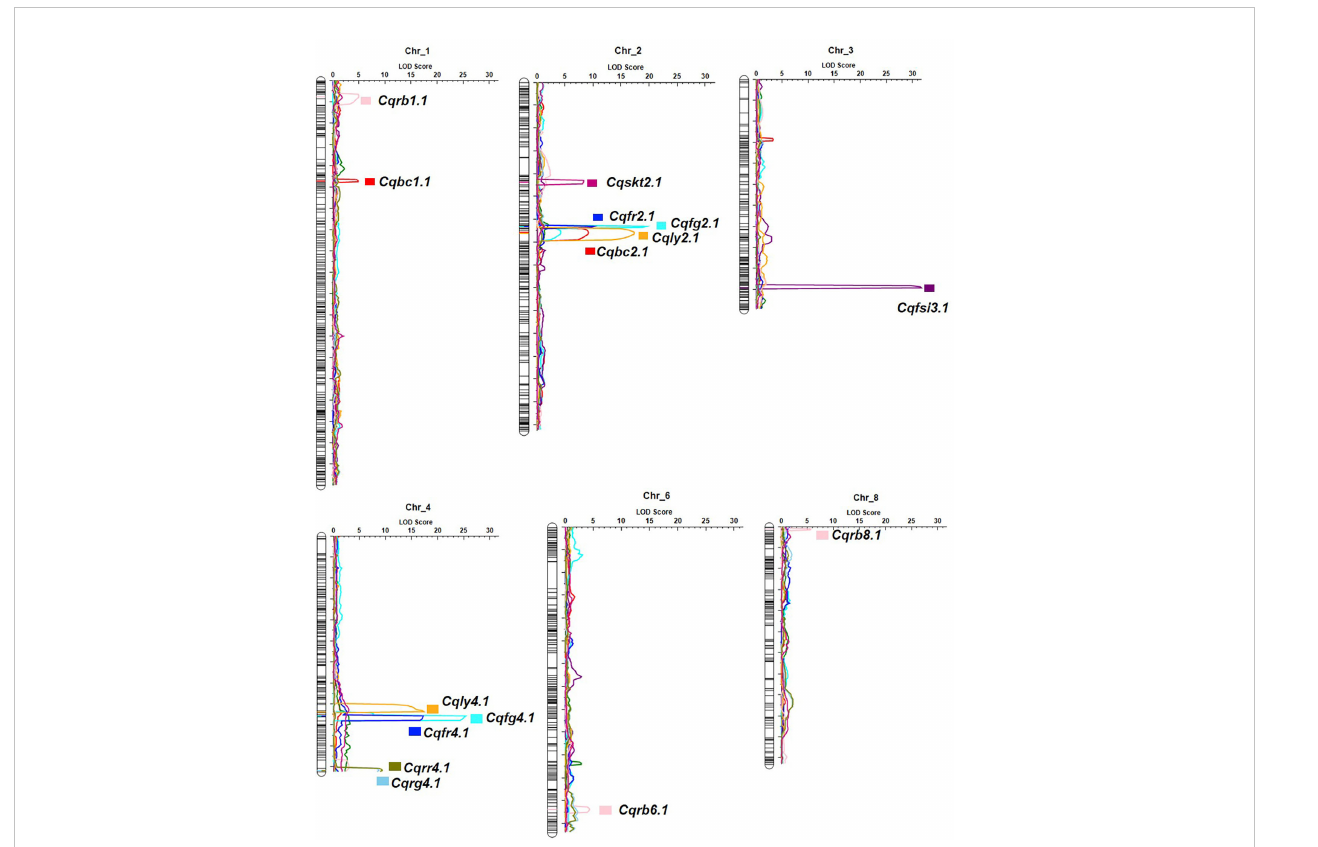
FIGURE 5 Genome-wide QTL mapping of fruit quality-related traits in the F 2 population. The boxes on the right of the chromosomes represent QTLs for fruit shape index (Cqfsi3.1), skin thickness (Cqskt2.1), lycopene (Cqly2.1 and Cqly4.1), b -carotene (Cqbc1.1 and Cqbc2.1), fl esh color (Cqfg2.1, Cqfg4.1, Cqfr2.1, and Cqfr4.1), and rind color (Cqrb1.1, Cqrb6.1, Cqrb8.1, Cqrg4.1, and